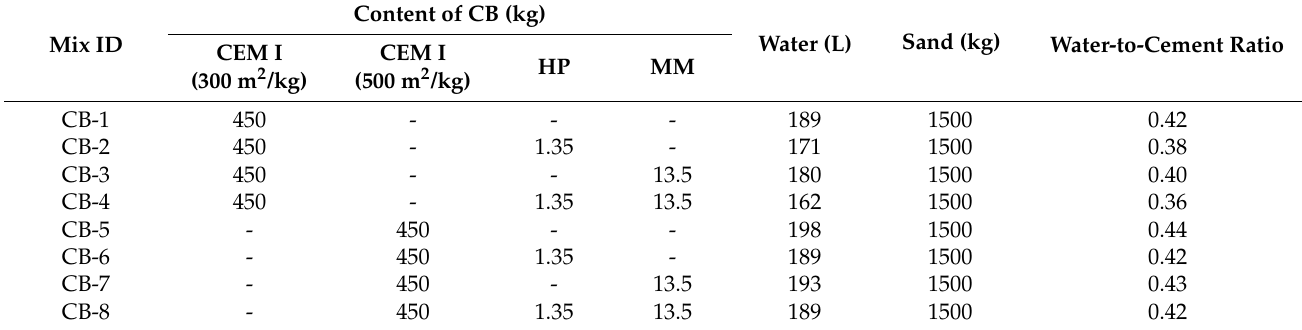
Table 3. Mix proportions of CB.